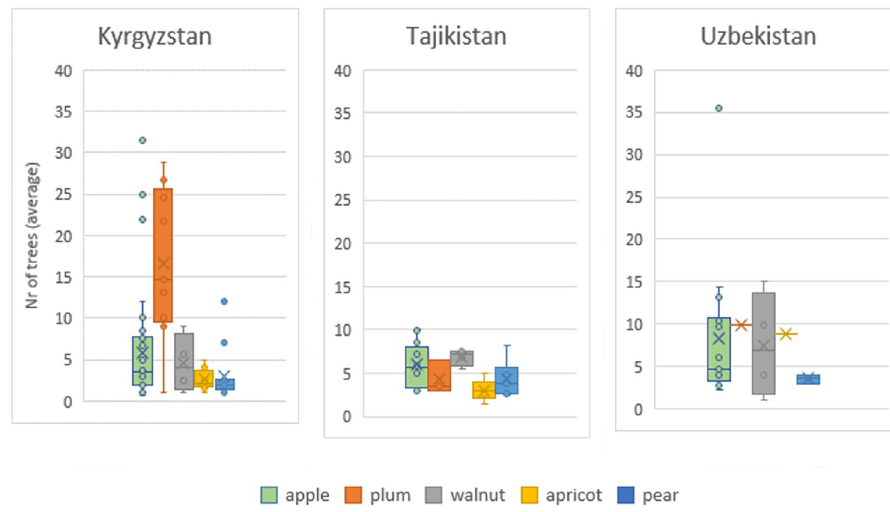
Fig 6. Boxplot with average number of trees per variety, by species and country, for the five most abundant species. Average values are calculated considering only home gardens where each variety occurred. https://doi.org/10.1371/journal.pone.0271398.g006 Those who collected planting material in the forest believed that this material was well adapted to local conditions and free of charge. They also noted that some species/varieties of interest to them were not available in the market. In Kyrgyzstan, farmers who did not collect planting material from the forest preferred other sources for various reasons: they did not know how to graft trees, the forest was too far away, or they did not have access to the forest plots allotted to households as long-term leases as part of forest co-management arrangements with the state. Those who collected planting material from the forest appreciated wild seedlings for their potential good root system, which made them ideal as rootstock for grafting high quality trees, and for their reportedly high survival rate. In addition, they stated that wild seed- lings did not suffer from root diseases, bore fruits constantly, and needed relatively little water. Nurseries other than those run by the Forestry Enterprise were managed by smallholder farmers. Often based on specific farmer requests, these small nurseries provided fruit tree